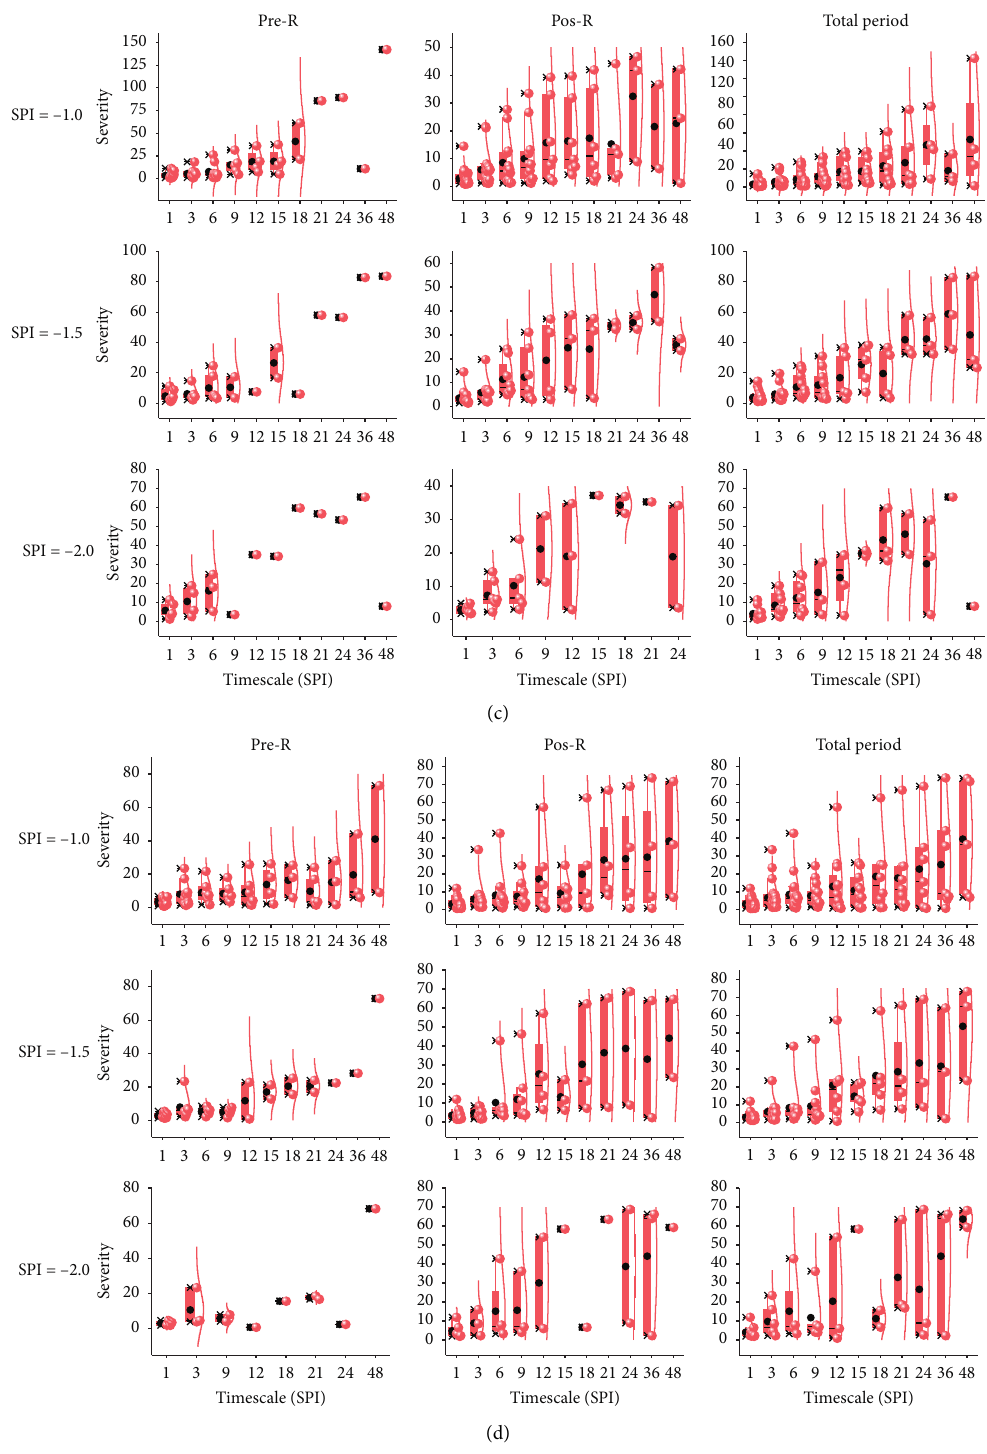
Figure 3: Boxplots showing MD duration and severity in the UHRB (a, c) and in the MHRB (b, d) based on SPI using thresholds of − 1, − 1.5, and − 2 for different timescales at different periods (the dot and midline in the boxplots are the mean and median; the upper and lower boundaries of box are the interquartile